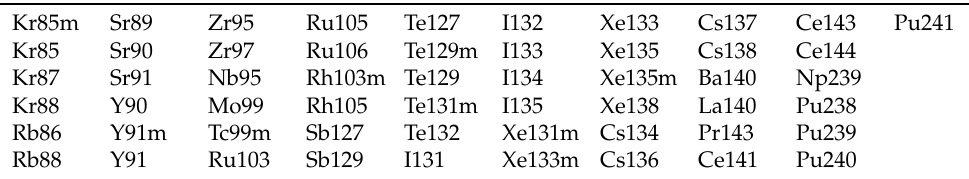
Table 1. List of isotopes significant in radiological-impact calculations in case of events in a nuclear facility and applied in ESTE